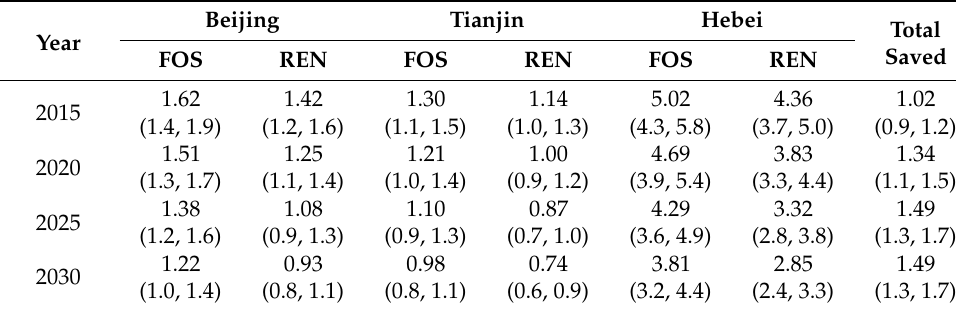
Table 8. Work loss days (unit: 10 million days) 1